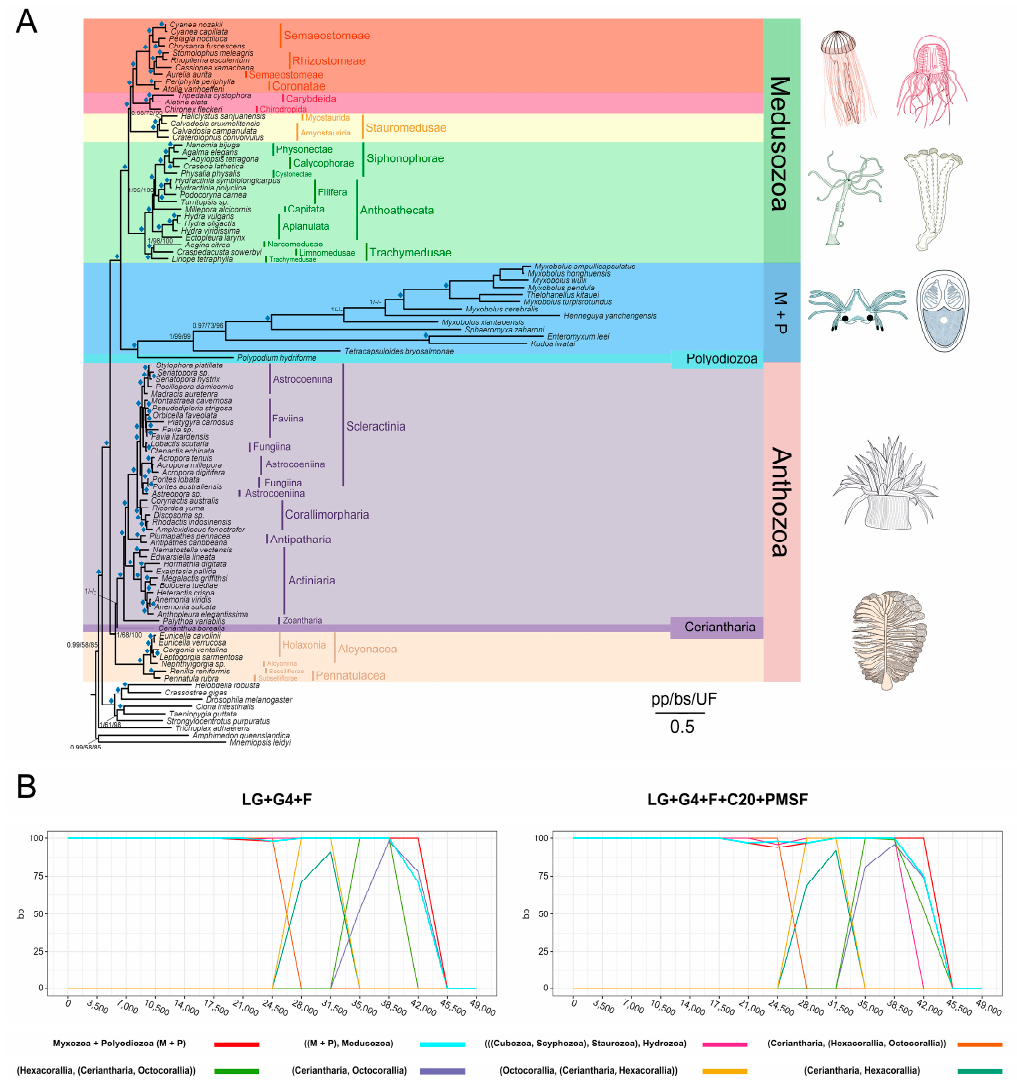
Figure 5. ( A ) Tree of Cnidaria. The topology was inferred from the concatenated amino acid sequence (main matrix 4_103tx_146og, 103 species, 51,598 positions) using PhyloBayes. Values at nodes are posterior probabilities (pp) under CAT + GTR + Γ 4, nonparametric ML bootstrap (bp) values obtained from 100 ML replicates using the PROTGAMMAAUTO model implemented in RAxML, and ultrafast bootstrap (UF) values from IQ-TREE under the LG + Γ 4 + FMIX (empirical, C20) + PMSF model. Diamond marks on branches correspond to 1.0 Bayesian pp and >95% bp and UF. Dashes represent the alternative maximum likelihood topology. ( B ) Fast-evolving site removal analysis. Sites were sorted based on their rates of evolution estimated under the LG + Γ 4 + F model and were removed from the data set according to rates (from highest to lowest). In each step, 3500 of the fastest evolving sites were removed. The bootstrap values for each bipartition of interest are plotted under LG + Γ 4 + C20 + F + PMSF.